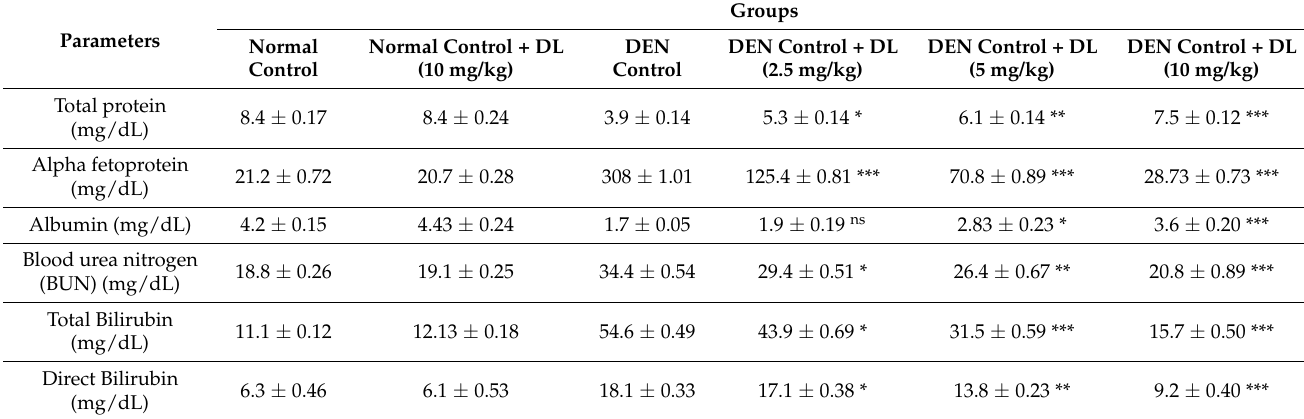
Table 3. Effect of DL on liver parameters.